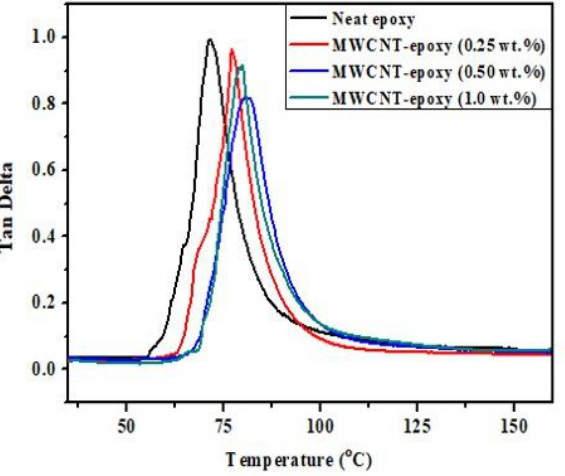
Figure 9: Tan δ versus temperature ( ∘ C) of neat epoxy and